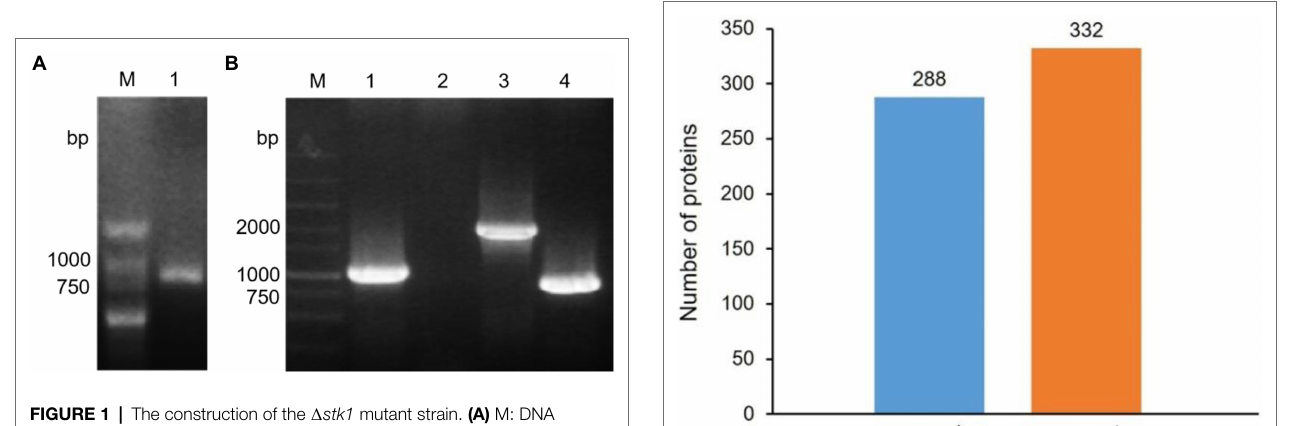
FIGURE 1 | The construction of the ∆ stk1 mutant strain. (A) M: DNA marker; 1: the fragment containing the upstream and downstream homology arms of stk1 was amplified by fusion PCR with primers ∆ stk1 -F1 and ∆ stk1 -R2 used to construct the recombinant plasmid pRE112- ∆ stk1 . (B) M: DNA marker; 1 and 2: the DNA fragments of stk1 were amplified by PCR with the primers ∆ stk1 -F3 and ∆ stk1 -R3 using the wild-type strain (lane 1) and ∆ stk1 strain (lane 2) chromosomal DNA as templates; 3 and 4: the long DNA fragments containing stk1 were amplified by PCR with the primers ∆ stk1 -F4 and ∆ stk1 -R4 using the wild-type strain (lane 3) and ∆ stk1 strain (lane 4) chromosomal DNA as templates.